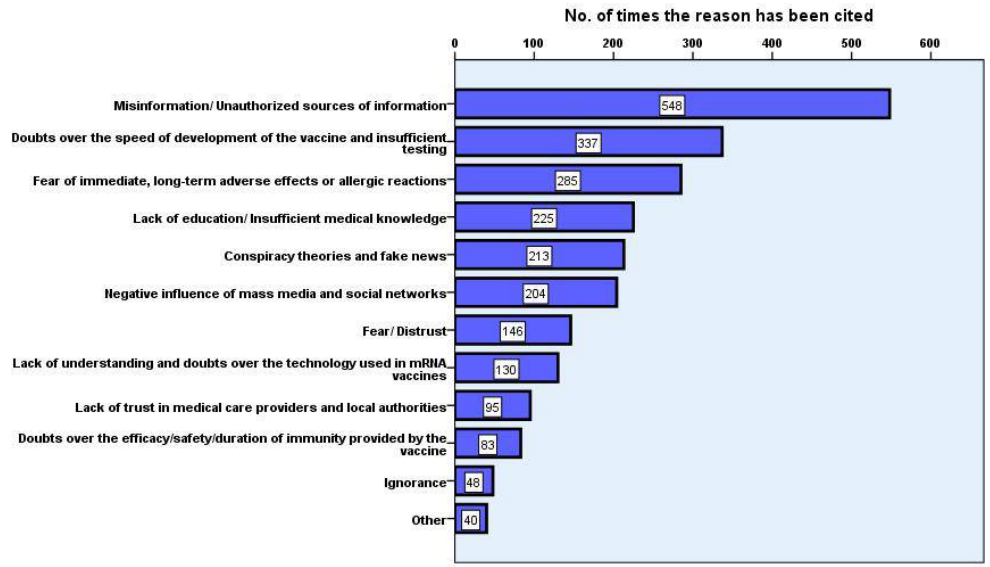
Figure 3. General themes regarding students’ perceptions of the general population’s reasons for COVID-19 vaccine hesitancy/refusal. Several themes have been identified as recurrent in the responders’ replies and chosen for their frequency to be visualised on the bar plot.